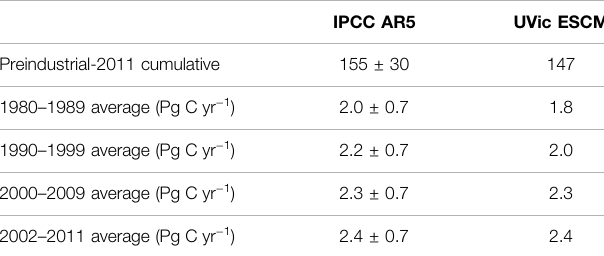
TABLE 1 | Model-simulated global oceanic CO 2 uptake compared with observation-based estimates reported by IPCC AR5, which show uncertainties as 90% con fi dence intervals